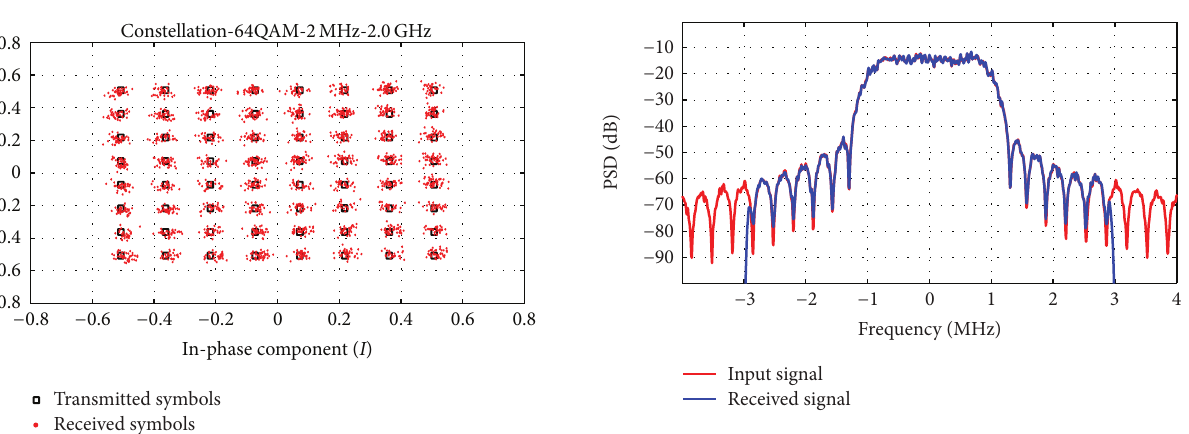
Figure 8: Transmitted and received frequency spectrums of a 64- QAM signal having 2 MHz bandwidth for low-IF receiver.